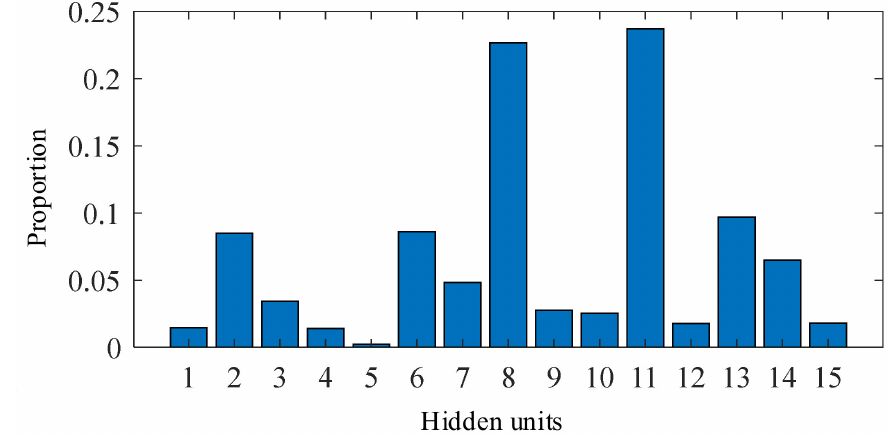
Figure 15. The results of the attention mechanism.